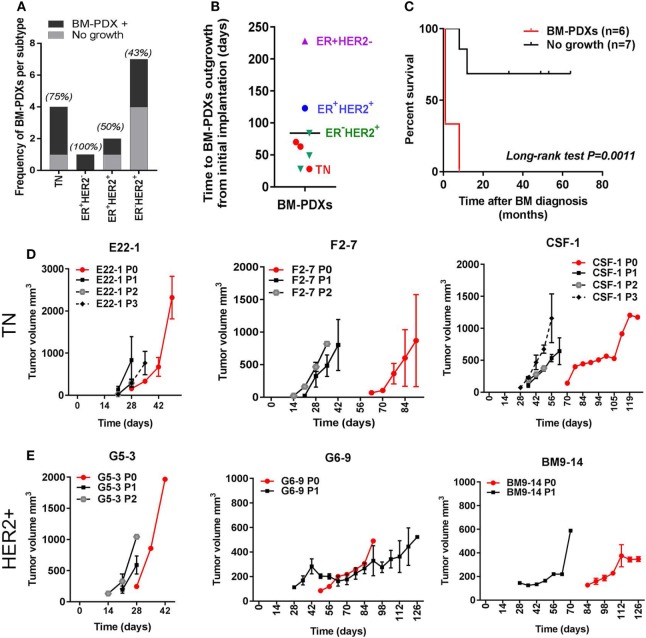
Establishment of brain-metastases-patient-derived xenografts (BM-PDXs) from breast cancer. PDXs were established in NOD/SCID/ILIIrg−/− mice, and subsequently propagated via direct transplantation of solid tumor pieces into new recipient mice. Tumors were grown under continuous estrogen supplementation. (A) BM-PDXs established as a function of breast cancer subtypes. Graph depicts the number (bars) and percentage of BM-PDXs established (BM-PDXs+) per tumor subtype compared to tumors that did not grow after 8 months of implantation. (B) Time in days from initial implantation to outgrowth as measurable tumors (~62.5 mm3) for all PDXs, colors indicate breast cancer subtypes. (C) Survival (months) after brain metastases diagnosis of patients with breast cancer whose surgical samples had in vivo tumorigenic potential (n = 6), or not (n = 7). Log-rank (Mantel-Cox) test P value is shown. (D,E) Tumor growth after implantation (P0, red lines), and subsequent passaging (P1, P2, P3, black/gray lines) in (D) TN and (E) ER−HER2+ BM-PDXs. For P0, 1–2 tumors were implanted in a single recipient. For P1-P3, data shows average tumor volume from two tumors in 1–2 recipient mice.